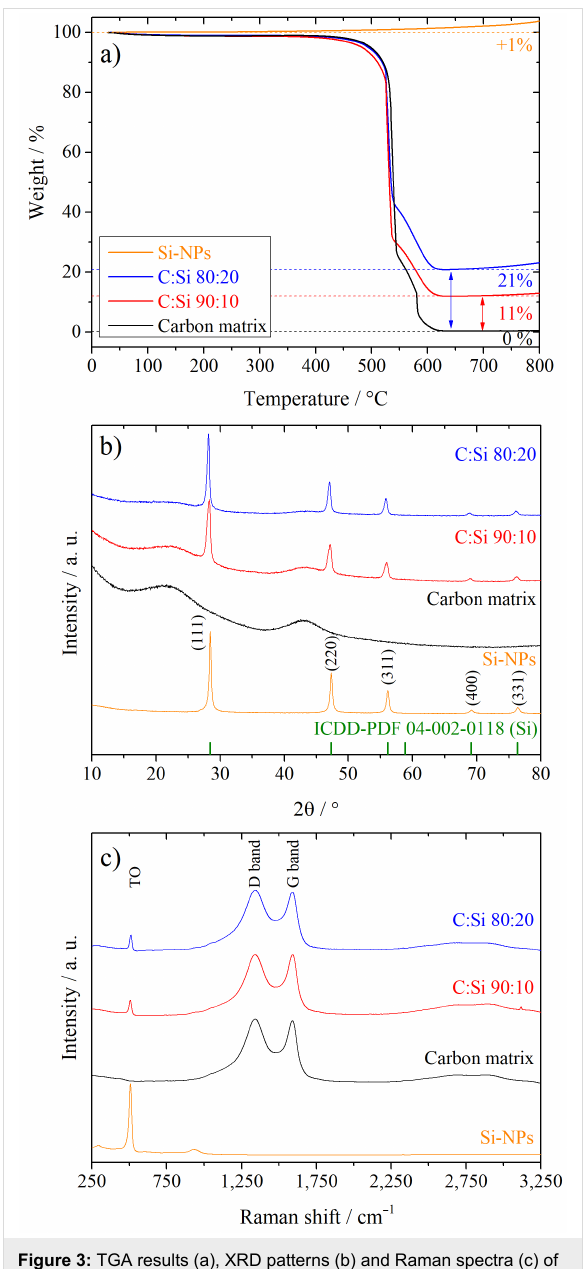
Figure 3: TGA results (a), XRD patterns (b) and Raman spectra (c) of the Si/C composites with a carbon to silicon ratio of 100:0, 90:10, 80:20 and the pure